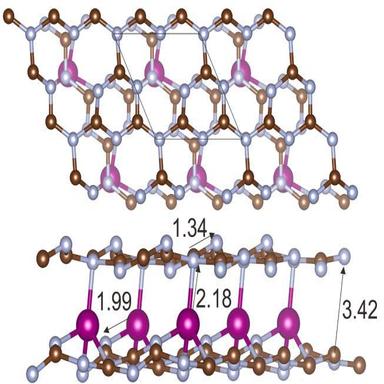
The atomic structure of (Mn)@(g-CN1)2. Nitrogen atoms are depicted in grey, carbon atoms depicted in brown, manganese atoms are in purple. The unit cell is indicated by a parallelogram. Bonds are indicated with arrows and the lengths are presented in Angstroms.